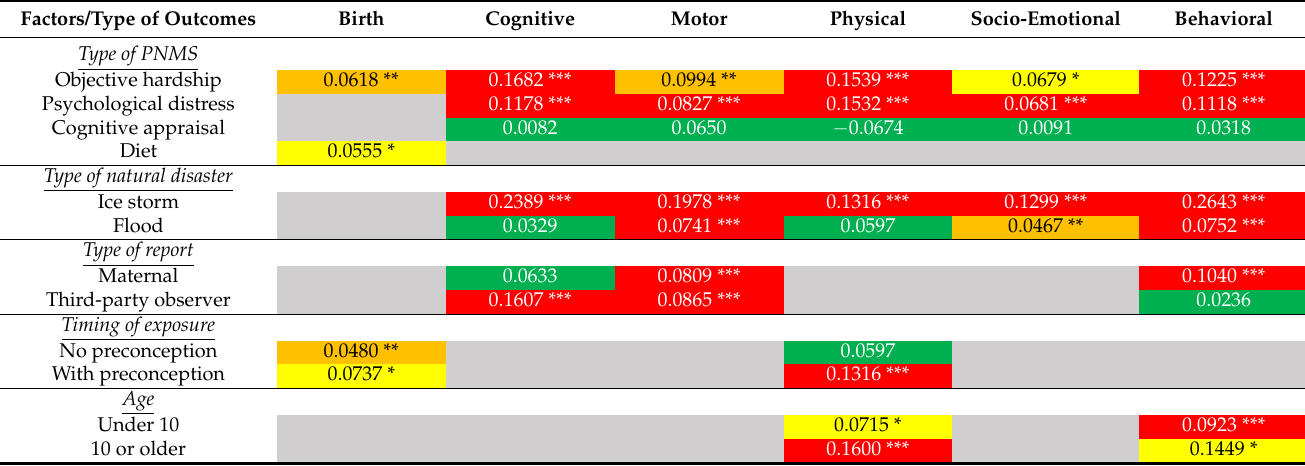
Table 2. Effects of factors on the association between PNMS and child development outcomes. Numbers represent the PNMS effect for the factor category. Grey: not tested; Green: not significant; Yellow *: p < 0.05; Orange **: p < 0.01; Red ***: p <